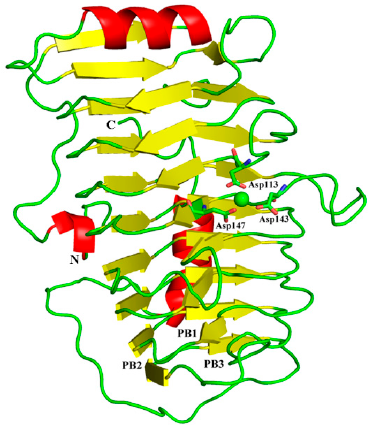
Figure 1. Overall structure of BacPelA. The three β –sheets are denoted as PB1, PB2, and PB3. Ca 2+ ion is shown as a green sphere. Approximately 70 crystal structures of Pels are available in the Protein Data Bank (PDB). They typically have one of two core structure folds, a right-handed β -helix, or an ( α / α ) n toroid [27]. Although the overall tertiary structure of BacPelA was similar to those of other Pels in PL1, which have the right-handed β -helix fold [4,5,28–31], there were some differences in the details. A structure complex model with substrate and Ca 2+ was con- structed by superimposing the structure of BacPelA and two highly homologous Pels: Bsp165PelA (PDB: 3VMW) containing pectate trisaccharide substrate (Figure 2A) or EcPelC (PDB: 2EWE) containing pectate tetragalacturonate substrate (Figure 2B). From the superimposed structures, there are two more loops in the T1 and T3 regions of Bsp165PelA (Figure 2A), and one more loop in the T1 region of EcPelC (Figure 2B) than in BacPelA. BacPelA has two more loops in the T3 and N -terminal regions than EcPelC. As reported previously, there is little similarity in the detailed structures of the T3 and T1 loops in PL family 1 members [32], while the most obvious difference lies in the long loop extending from the core structure in the T3 region [4,32]. In this region, BacPelA adopts a simple loop similar to that in Bsp165PelA, while EcPelC adopts a compound loop (accord- ing to the established taxonomy of loops) [5], and there are three α -helices in the T3 region of EcPelC, while no α -helix was found in this region of BacPelA or Bsp165PelA. In addi- tion, there are three α -helices consisting of more than one turn in the structure of BacPelA, two of which are located on the N- and C-terminal long loops folding along one side of the parallel β -helices, while the shortest is located in the T3 region. In Bsp165PelA and EcPelC, there are four and seven α -helices, respectively.